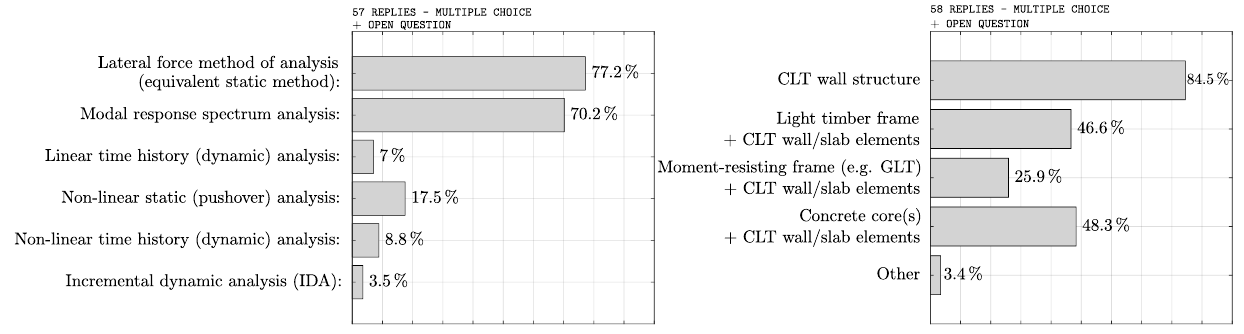
Figure 17. Seismic design with cross laminated timber (CLT). Type of analysis used for seismic design ( left ) and structural systems used in combination with CLT ( right ).